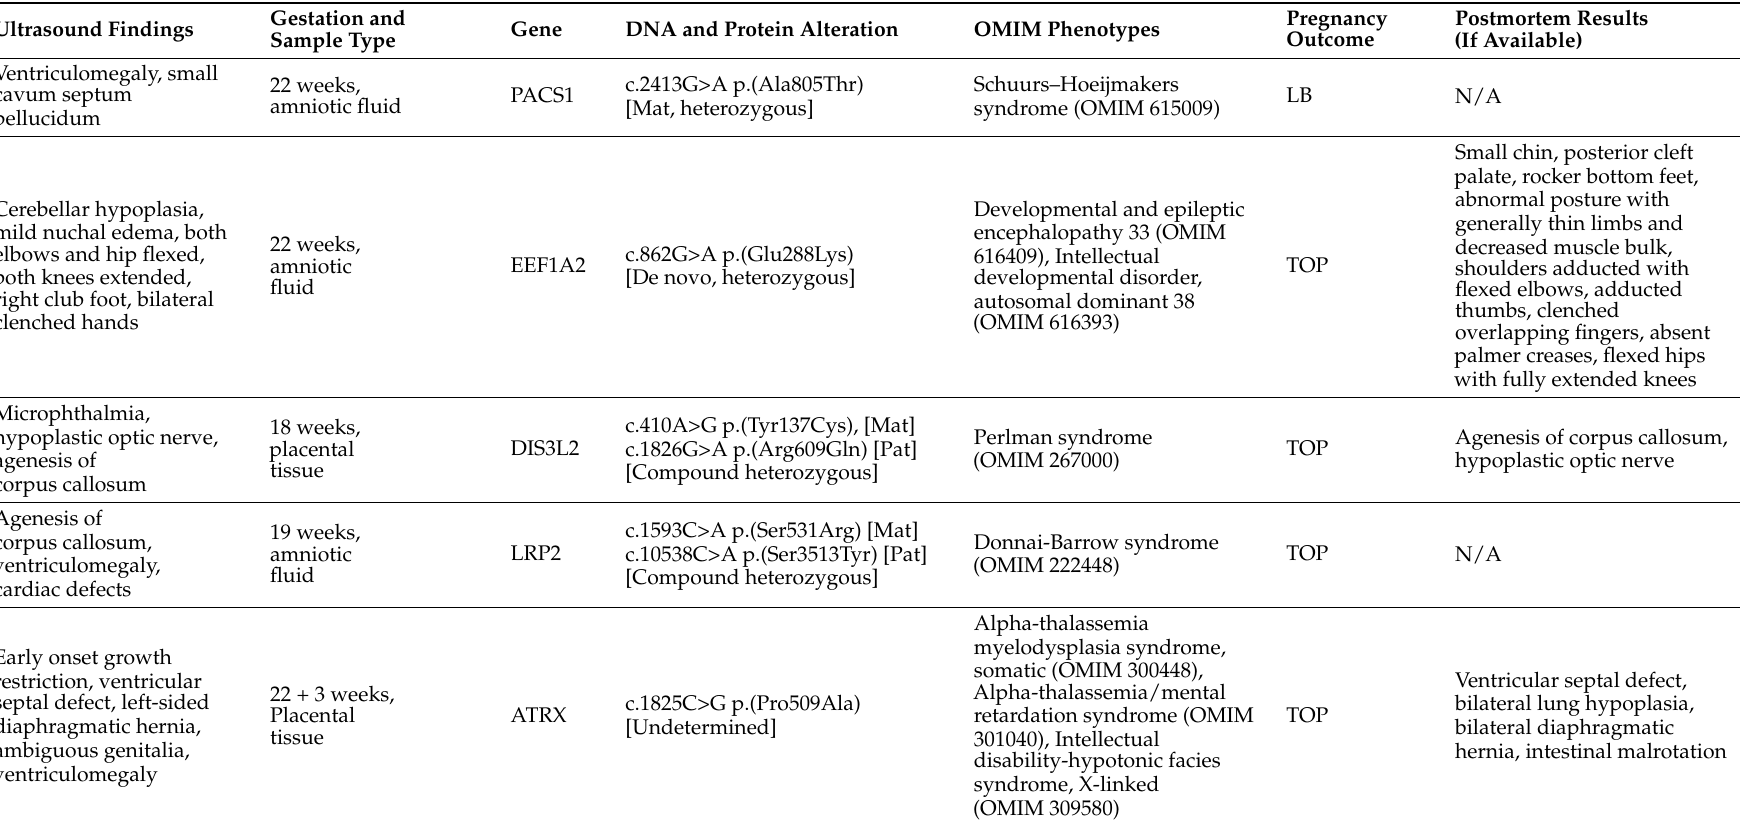
Table 2. List of variants with uncertain clinical significance identified by prenatal